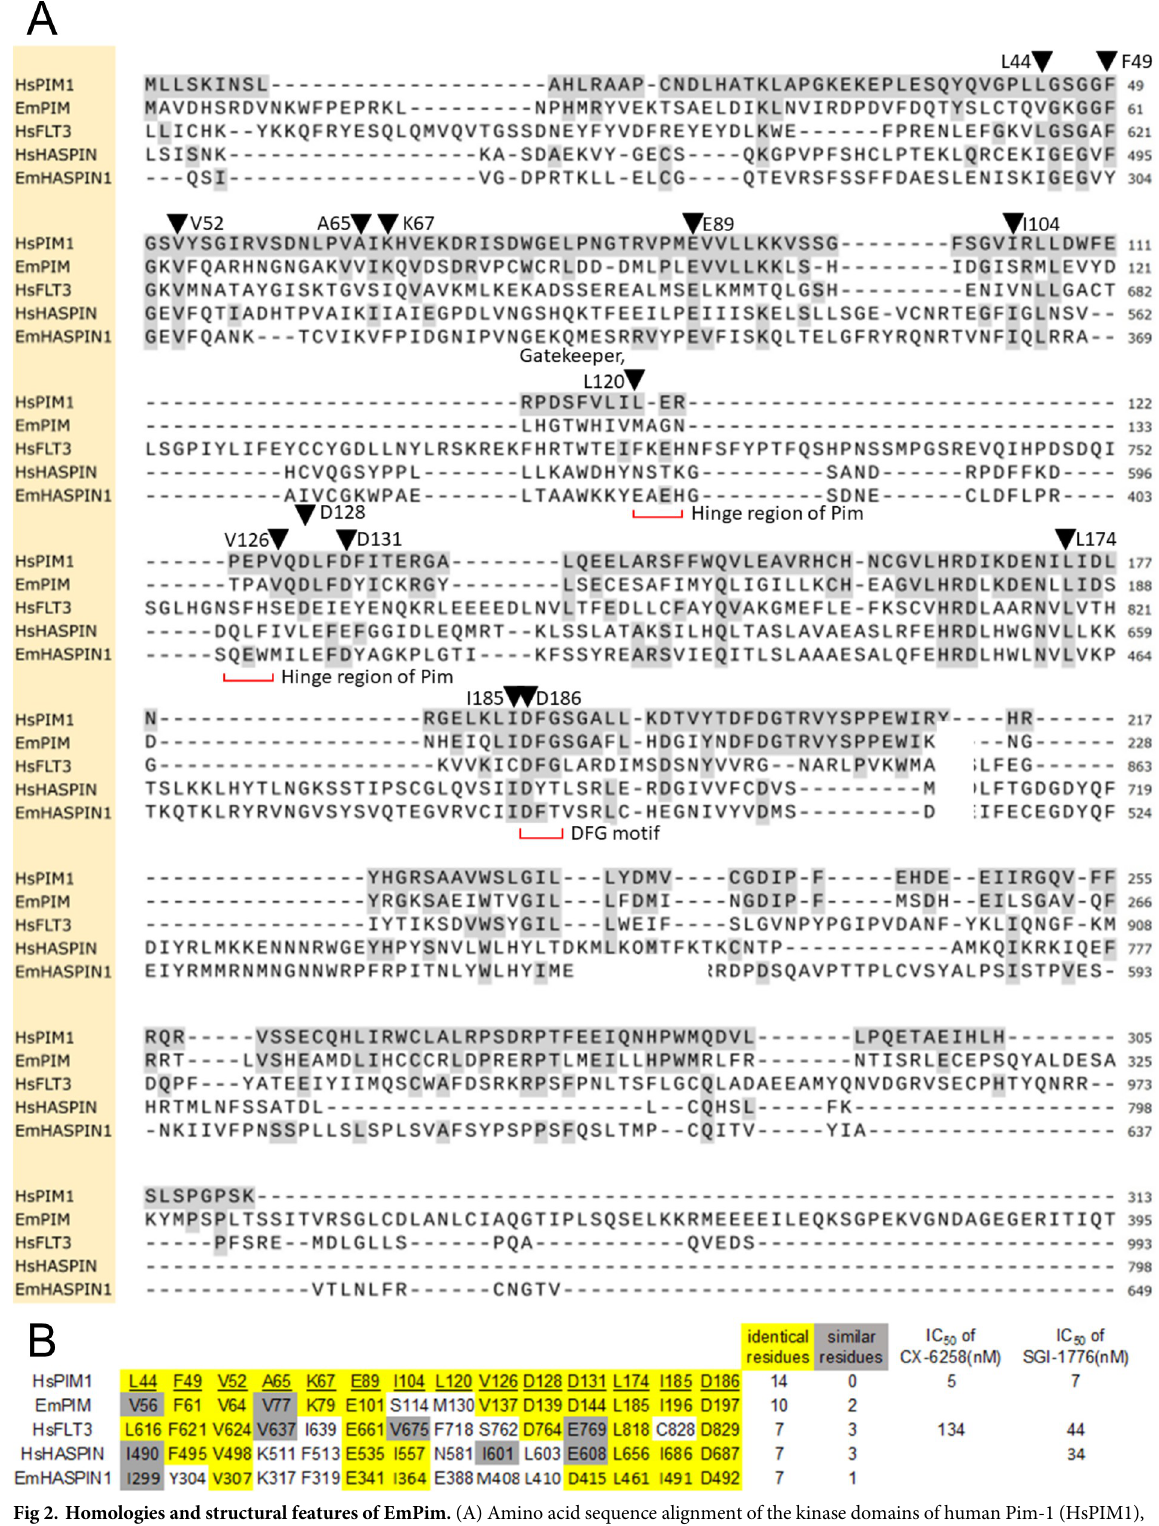
PLOS NeglectedTropical Diseases | https://doi.org/10.1371/journal.pntd.0010483 October 3,